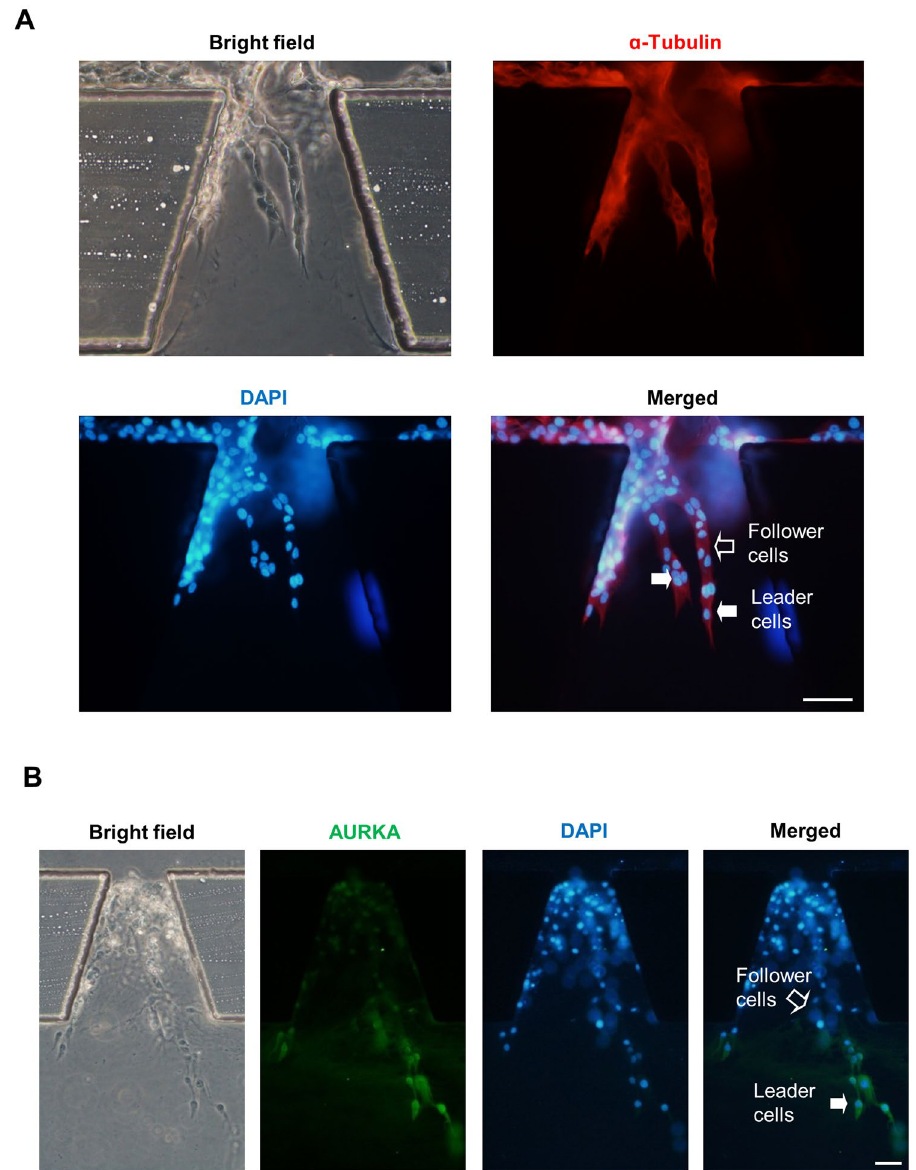
Figure 2. The different expression levels of AURKA in the leader cells and the follower cells. ( A , B ) MDA-MB-231 cells were cultured in microfluidic chip for 2 days and subjected to immunofluorescence staining and analysis (original magnification, × 200) with antibodies against α -Tubulin (red, A ) and AURKA (green, B ). DAPI (blue) staining was used to visualize the nuclei. Solid arrows point to the leader cells while the hollow arrow points to the follower cells. Scale bar: 100 μ m ( A ) and 100 μ m ( B